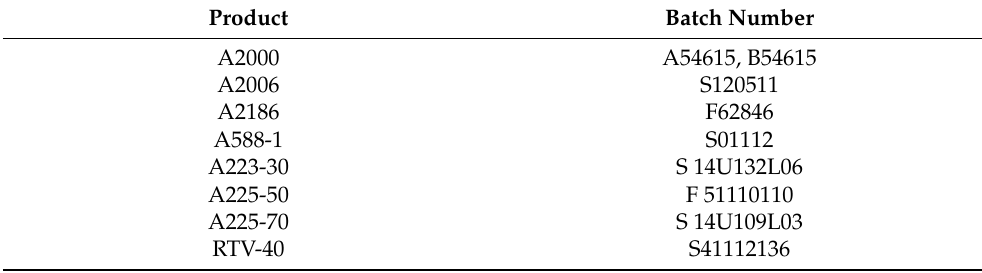
Table 1. Prosthetic Elastomers Tested in This